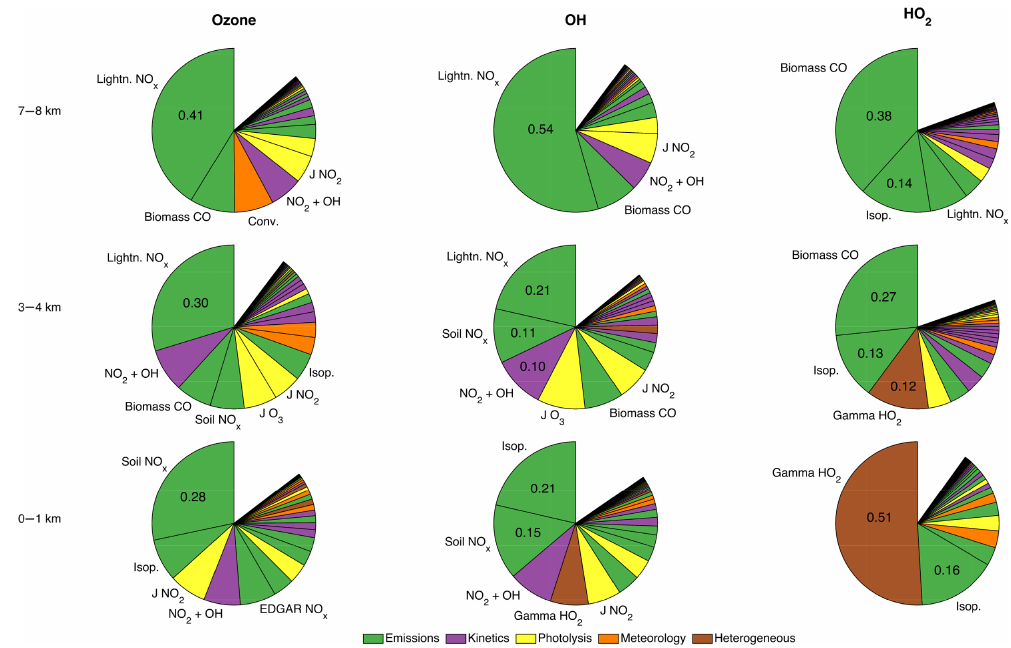
Figure 7. First-order sensitivity indices for median flight track ozone, OH, and HO 2 for INTEX-B flights originating from and terminating in Houston. Legend categories are defined in Table 2. Sensitivity indices are labeled in pie slices for factors for which S i ≥ 0 . 10.